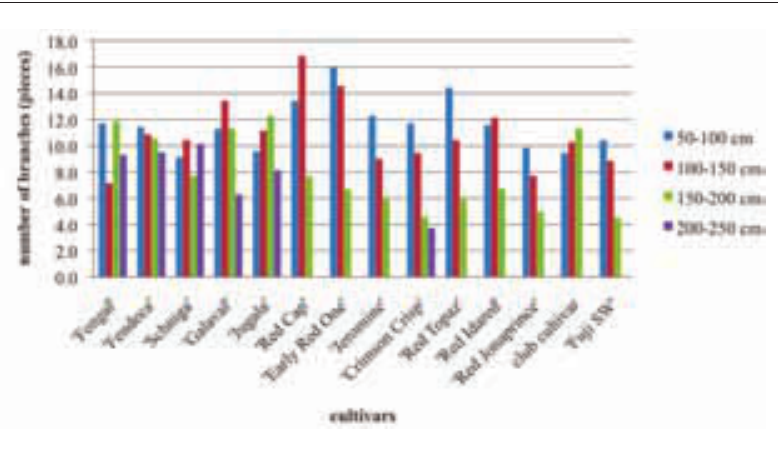
Figure 4: Average number of the branches in different height zones of the central leader (pieces) (Nyírbátor, 2013)